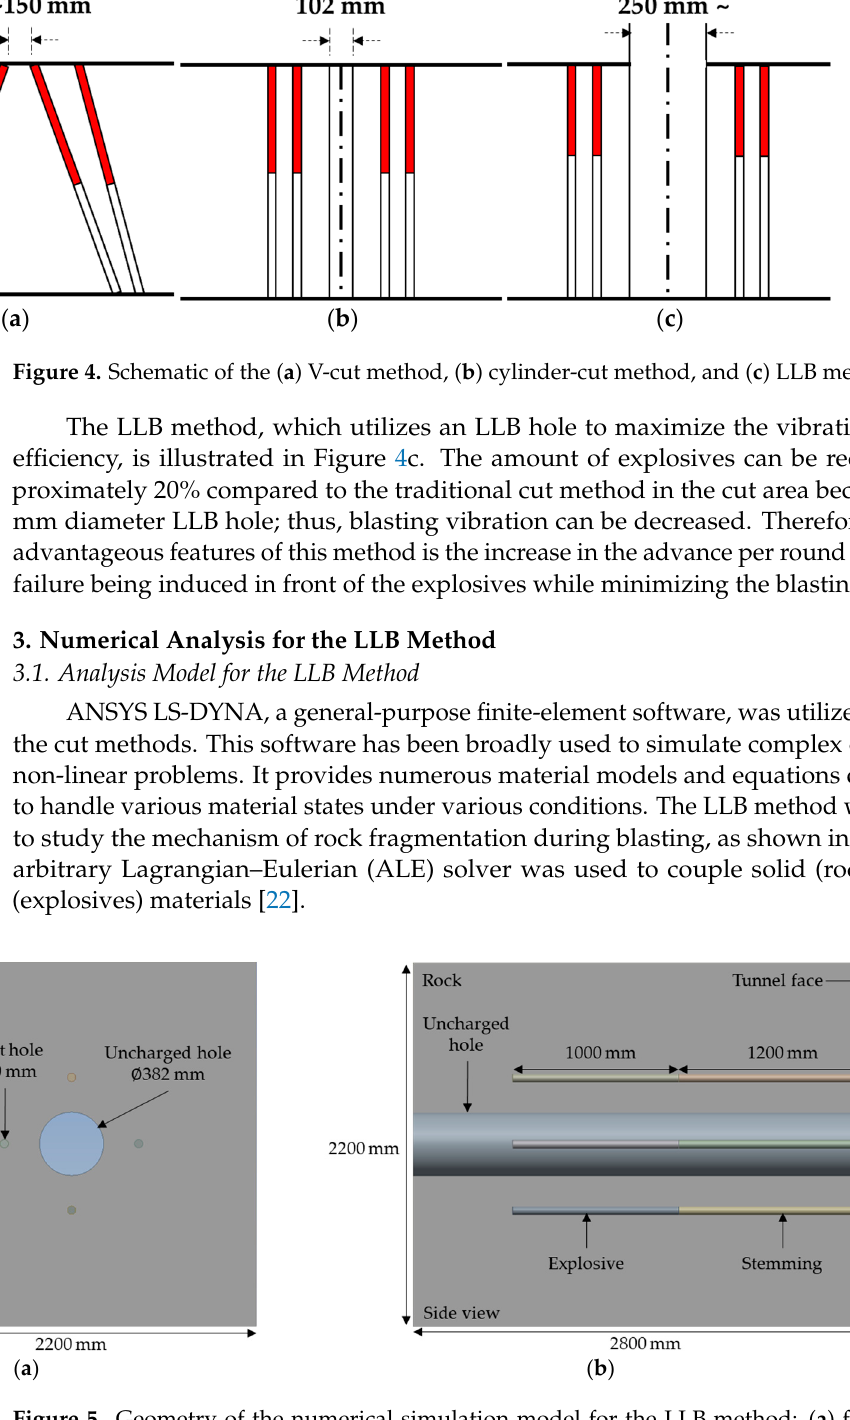
Figure 5. Geometry of the numerical simulation model for the LLB method: ( a ) front view and ( b ) side view.